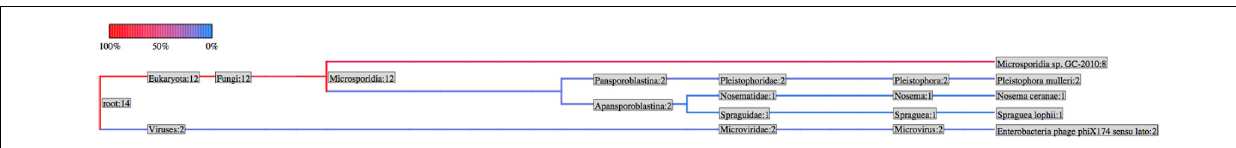
FIGURE 6 | Taxonomy of unmapped reads assembled into contigs. A graphical representation of the number of contigs mapping to each level of the NCBI Taxonomy. The colors represent the number of contigs mapping to each branch.